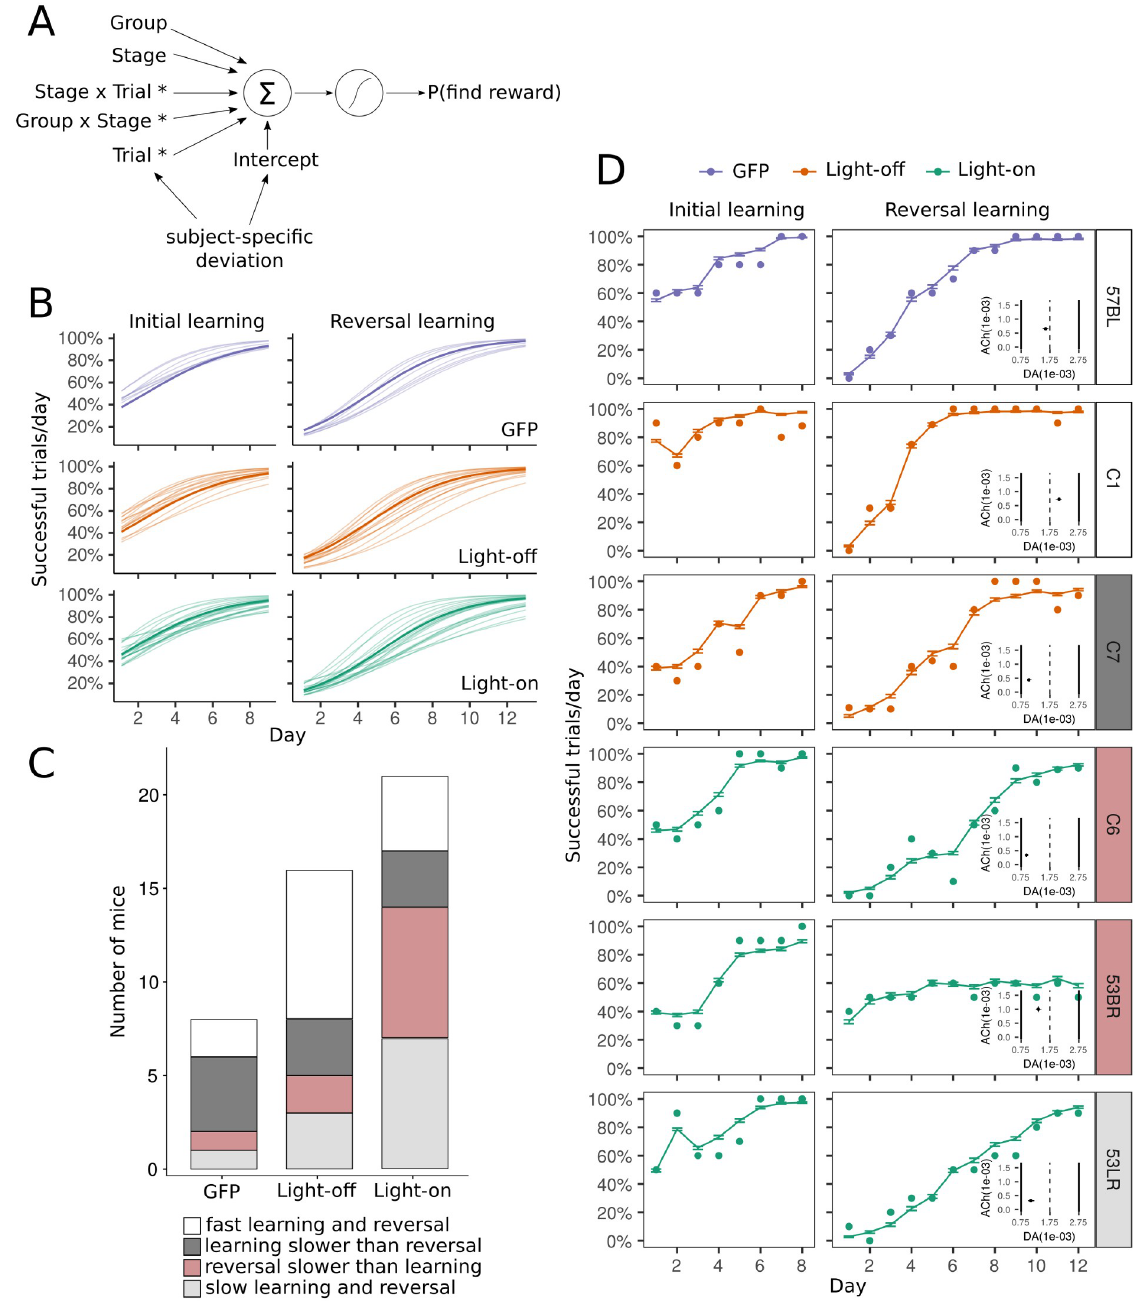
Fig 3. Heterogeneity in learning across mice. (A) Mixed-effects logistic regression fit to the experimental data. The five regressors used to predict the probability of a mouse locating the reward on each trial: group type (GFP, light-off or light-on), stage (initial learning or reversal learning), trial number, and interactions between the variables. Unique slopes and intercepts were estimated for all mice, which produced individual predictions shown in B. Asterisks indicate significant terms. (B) Estimated probability of individual mice locating the correct well on each day, after fitting the mixed-effects logistic regression to the data. (C) Types of learning behaviours in mice. Some mice were slower in the initial learning stage ( � 6 days to attain 80%) than they were at reversal learning. Others were slower in the reversal learning stage ( � 8 days to attain 80%) than they were at initial learning. There were also mice that performed consistently well (fast learning and reversal) or poorly (slow learning and reversal) across the two task stages. (D) Examples of model fits to individual mice. The sn-Plast model was fit to each mouse by comparing the RMSE of the percentage of correct trials across days between the mouse (filled circles) and the agent. This was repeated for each iteration of the model, producing 100 parameter estimates for each mouse. Simulated behavioural data across the 100 best fit estimates were then averaged to yield the performance curve (overlaid line). Error bars represent SEM. (inset) Final parameter estimate (x- coordinate, η ; y-coordinate, η ). Colours of the subject labels indicate the type of learning behaviour as described in C. DA ACh